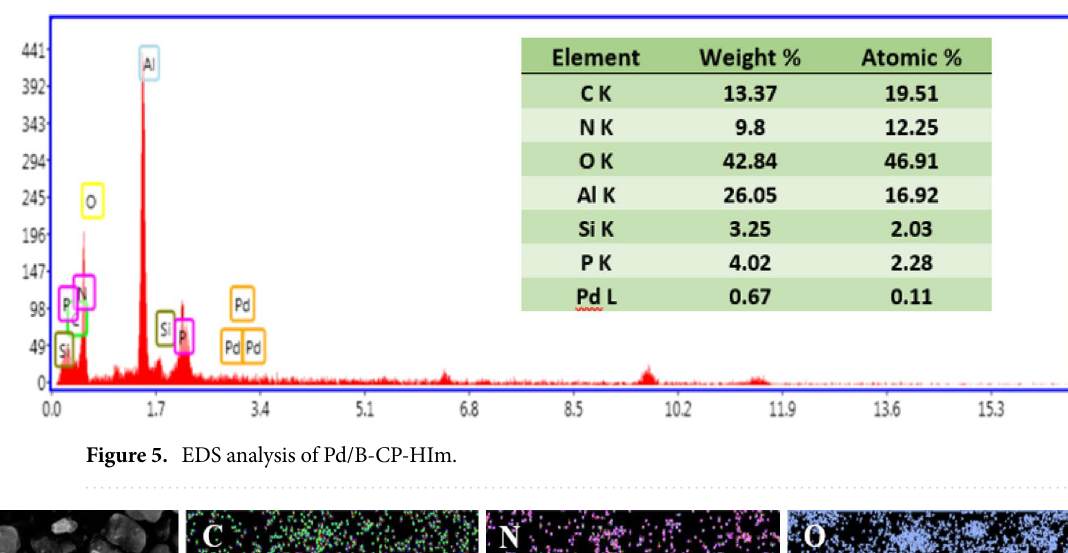
Figure 4. ( A ) TEM image of Pd/B-CP-HIm and ( B ) particle size distribution curve for Pd NPs.